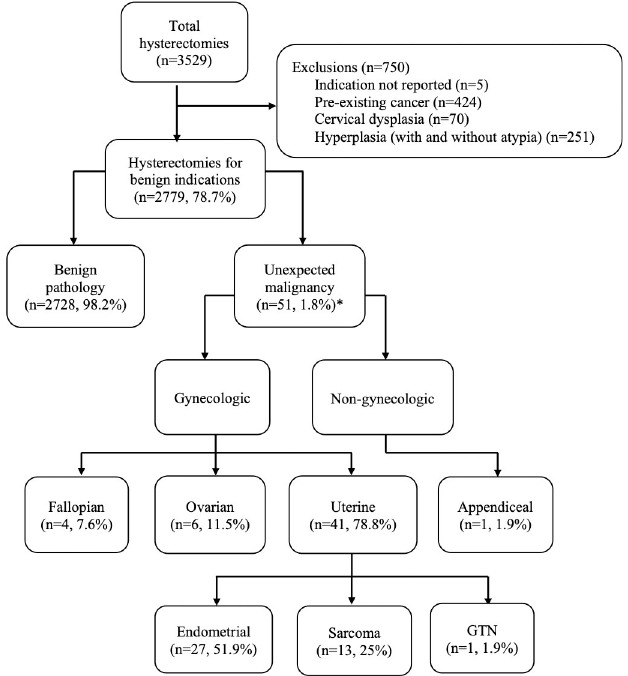
Fig 1. A flow diagram illustrating the number of unexpected malignancies on final pathology report for hysterectomy performed for benign indications. � 51 patients had an unexpected malignancy with one patient having two malignancies (endometrial and appendiceal) (n = 52 total unexpected malignancies). https://doi.org/10.1371/journal.pone.0266338.g001 number of unexpected malignancies in our cohort 52. The incidence of UM was 1.8% (51/2779). The most common gynecologic malignancy locations were uterine (endometrial (27/52, 51.9%), sarcoma (13/52, 25%) and gestational trophoblastic neoplasia (1/52, 1.9%)), ovarian (6/52, 11.5%) and fallopian tube (4/52, 7.6%). There were no occult cervical cancers (Fig 1). Among patients with UM, the most common indications for surgery were fibroids (19/51, 37.2%) and abnormal uterine bleeding (16/51, 31.3%). Most patients with unexpected sarcoma had fibroids (12/13, 92.3%), while most with unexpected ovarian or fallopian tube cancer had pelvic mass as a preoperative diagnosis (6/10, 60%) (Table 1). Table 1. Unexpected malignancy based on preoperative indication for surgery. Surgical indication